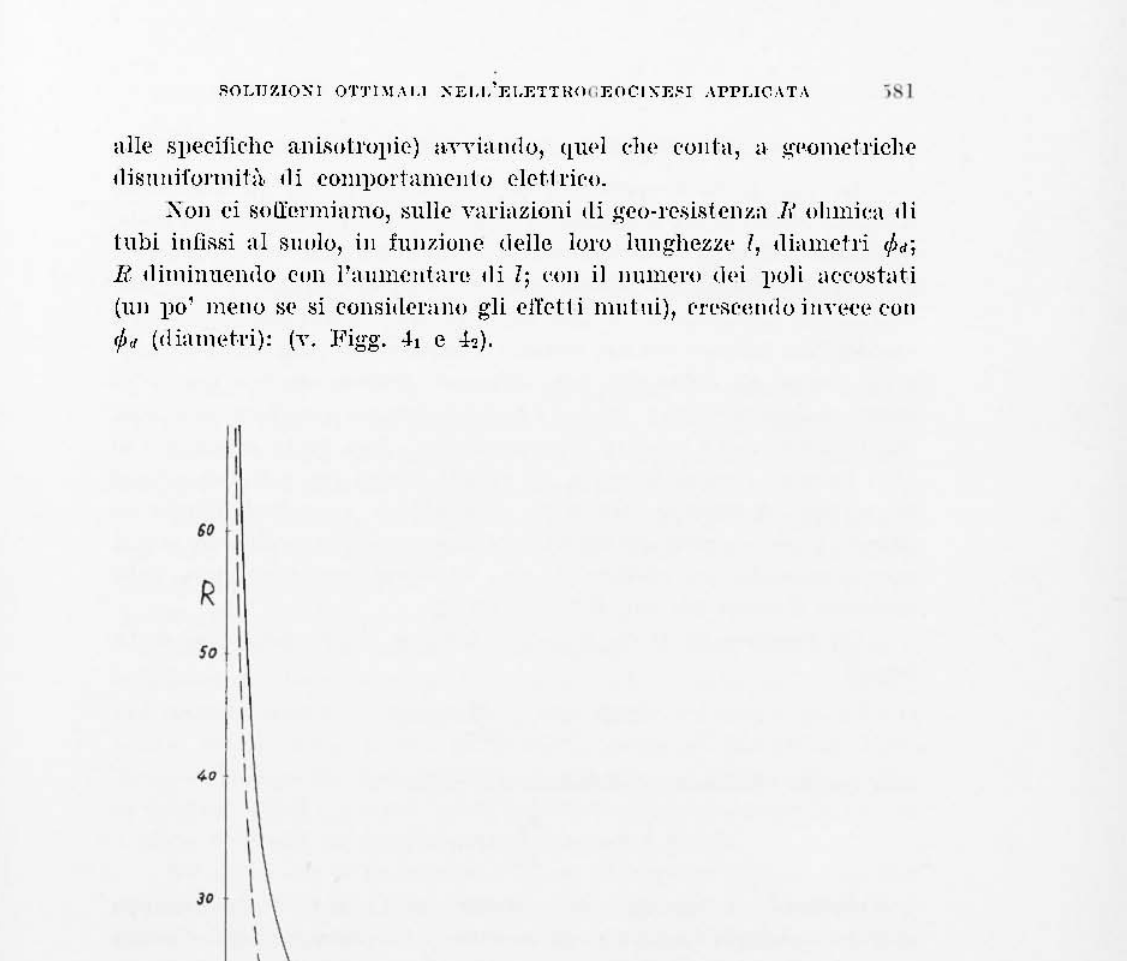
Fig, 42 - IlingmlJllJli (N,n) , L 'azi"lll' lJIutua H (", dnla d:dla Iill{'n {'olltilllIn; RPllza lJIul,na, /..raHI'ggiata. l'iallo polare (N, Il), N rpsislellza (iII